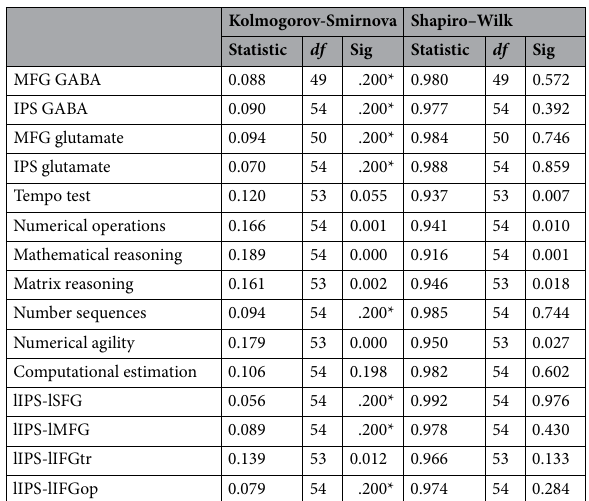
Table 4. Test of normality results table of the neurotransmitter and cognitive measures. l = left, SFG = superior frontal gyrus, MFG = middle frontal gyrus, IFGtr = inferior frontal gyrus pars triangularis, IFGop = inferior frontal gyrus pars opercularis, df = degrees of freedom, Sig. =